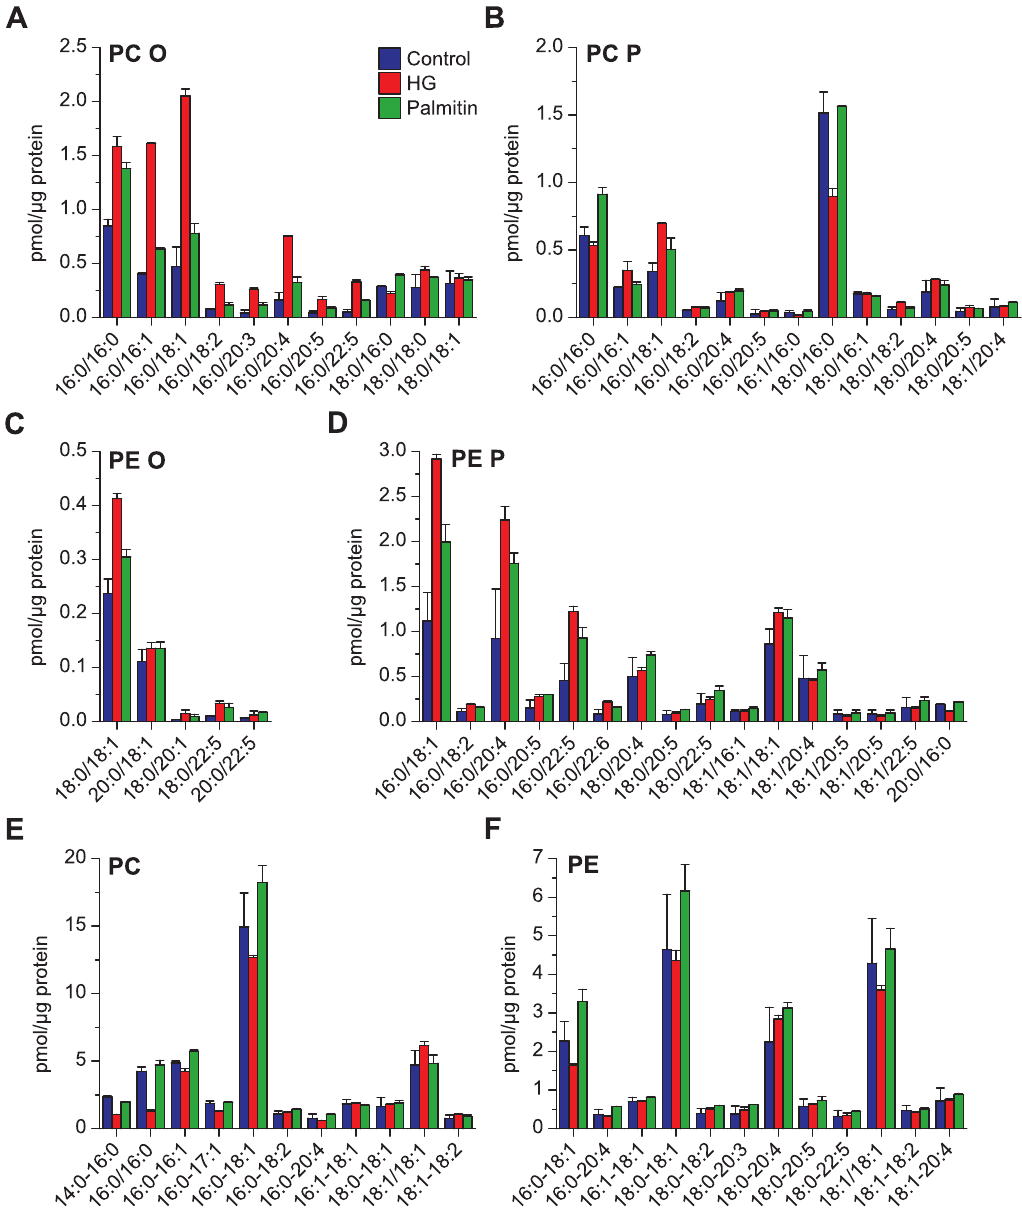
Figure 3. Quantitative analysis of glycerophospholipids after HG or palmitin treatment. The major species of ( A ) PC O, ( B ) PC P, ( C ) PE O, ( D ) PE P, ( E ) PC and ( F ) PE, in HEp-2 cells treated with HG (20 m M), palmitin (20 m M) or ethanol (0.1%, as control) for 24 hours. The species shown here are species comprising more than 1% of the total mass of the ether lipids and more than 2% of PC and PE for at least one of the samples.